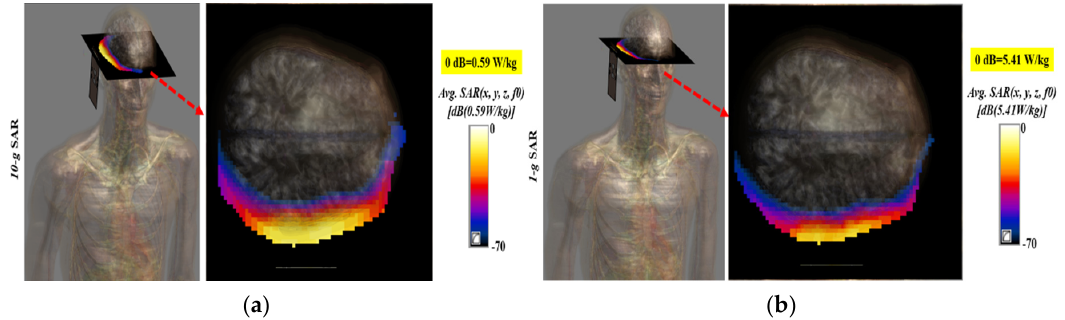
Figure 14. Specific Absorption Rate (SAR) at 5.9 GHz over: ( a ) 1 g; ( b ) 10 g standards.